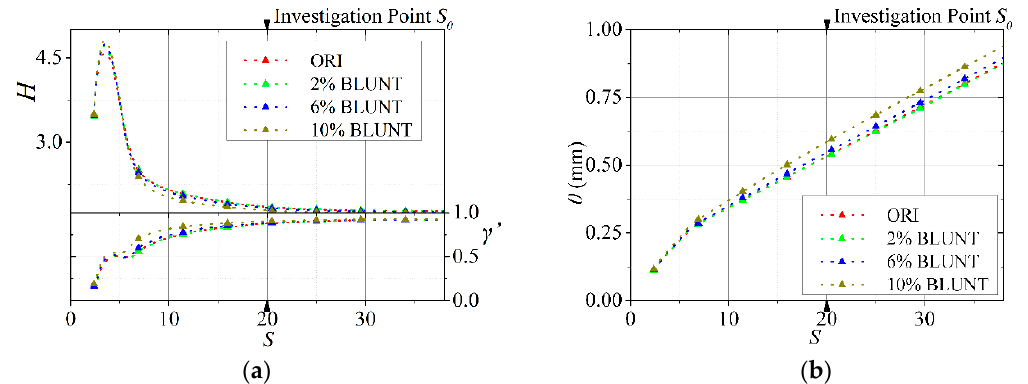
Figure 9. The BLUNT of Ellip.LE at Tu = 7%: ( a ) the boundary layer shape factor and normal average turbulence intermittency; ( b ) the momentum thickness along aerofoils.